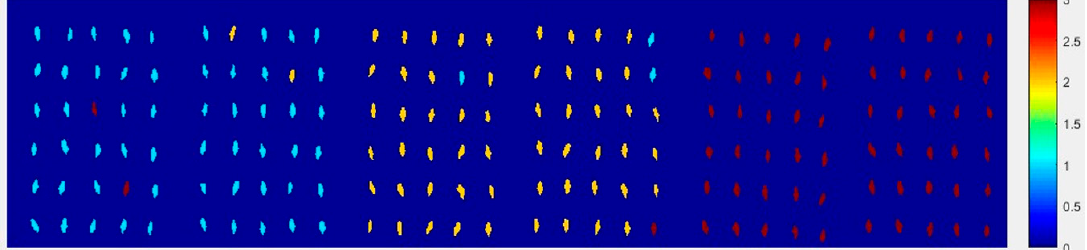
Figure 9. The final visualization images of Haoyu21 with the SPA and PLS-DA model with method M2P.